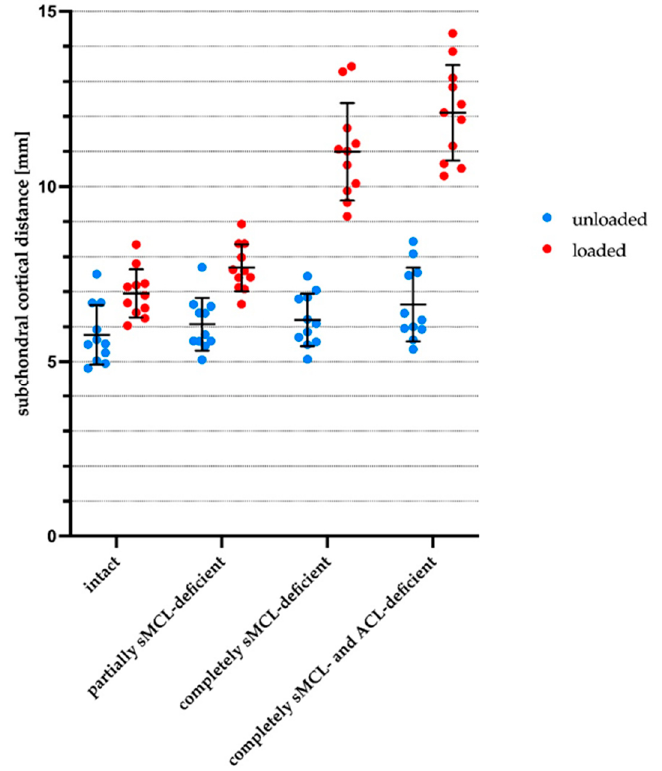
Figure 8. Scatter plots of mean subchondral cortical distances (as determined automatically) as a function of loading and graded knee joint ligament injury. Individual dots indicate mean subchondral cortical distances of each joint, (loading) configuration, and (joint) condition. Horizontal and vertical lines indicate means and standard deviations. Configurations are blue (unloaded) and red (loaded), while conditions are defined below the x-axis. Abbreviations as defined in Figure 6.